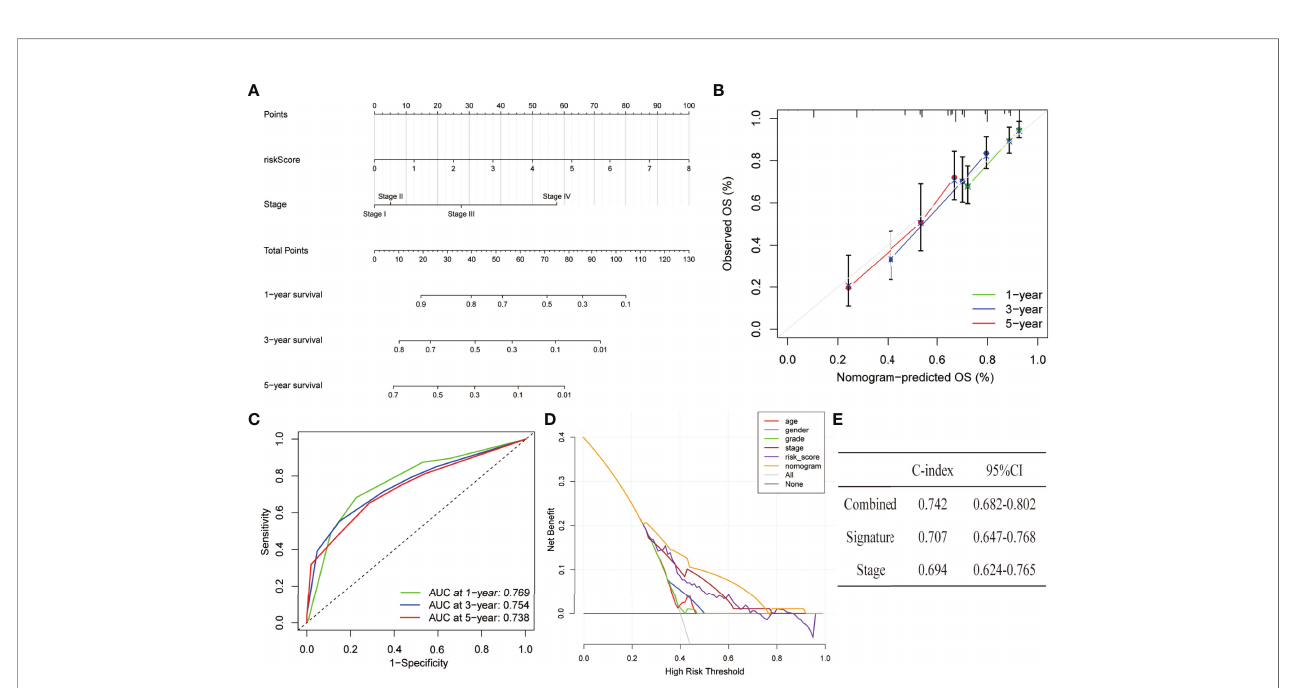
FIGURE 8 | Establishment and assessment of a nomogram in the entire set. (A) The nomogram predicts the probability of the 1, 3, and 5 years of OS. (B) The calibration plot prediction via nomogram of the OS at 1, 3, and 5 years. (C) ROC curves of the nomogram for predicting the 1, 3, and 5 years of survival. (D) Decision curve analysis for the nomogram, age, gender, grade, stage, and risk score. (E) C-index of the nomogram, signature, and